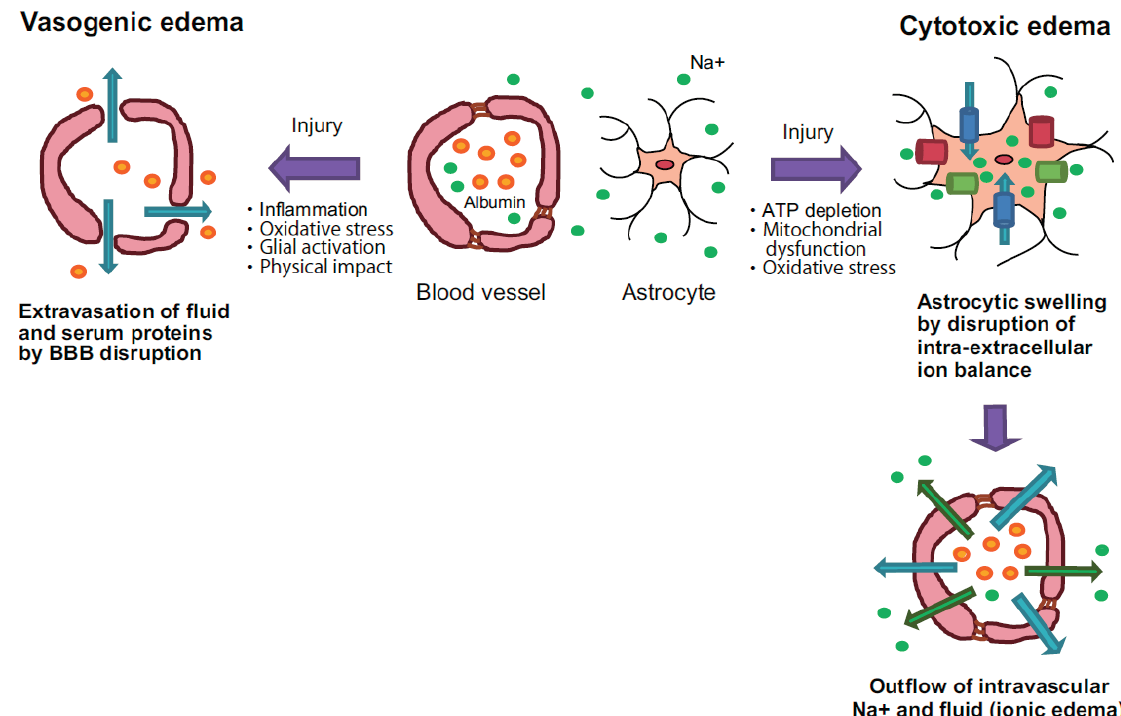
Figure 1. Pathology of vasogenic and cytotoxic edema. Vasogenic edema: After brain injuries, endothelial tight junctions are disrupted by inflammatory reactions and oxidative stress. Moreover, activated glial cells release vascular permeability factors and inflammatory factors, and these factors accelerate blood-brain barrier (BBB) hyperpermeability. These events cause extravasation of fluid and albumin, leading to extracellular accumulation of fluid into the cerebral parenchyma. Cytotoxic edema: Brain insults induce intracellular ATP depletion, resulting in mitochondrial dysfunction and oxidative stress. These events cause a disturbance of intra-extracellular ion balance. As a result, excessive inflows of extracellular fluid and Na + into cells are induced, leading to cell swelling. Because the extracellular Na + contents are decreased by excessive inflow into cells, the outflow of Na + and fluid from blood vessels is compensatorily accelerated. The intravascular Na + outflow results in extracellular fluid accumulation in the cerebral parenchyma. Blue arrows: flow of water, green arrows: flow of Na + , orange spheres: albumin, green spheres: Na + , blue columns: water channel, green columns: ion transporter and red columns: ion